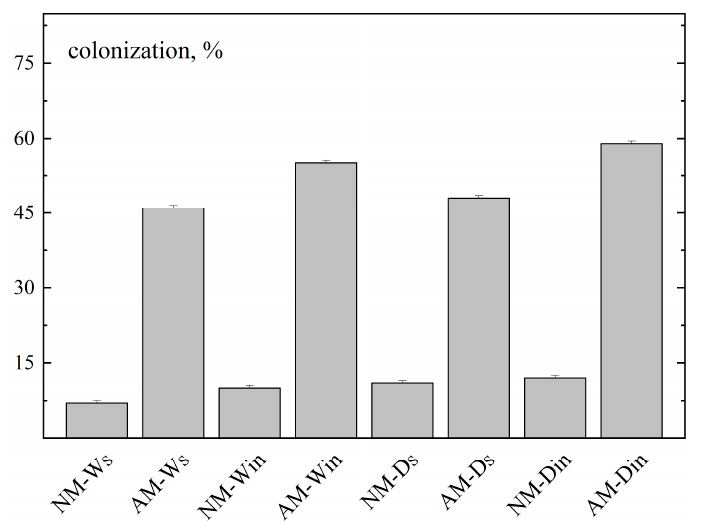
Figure 1. Mycorrhizal colonization (%) of P. peruviana roots: non-mycorrhizal ( NM ), inoculated with AMF ( AM ), well-watered ( W ), drought-stressed ( D ), seed-propagated ( s ), and in vitro propagated ( in ) plants. Values are mean ± SE, n = 9; common letters indicate no significant differences as assessed by Fisher LSD test ( p ≤ 0.05) following ANOVA.